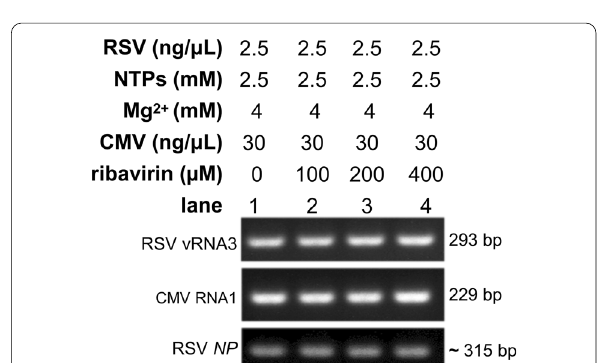
Fig. 5 The effect of ribavirin on the transcription of RSV. The chimeric RSV mRNA (RSV NP ) produced in vitro from each reaction with a mixture as indicated on top of the gel was amplified by RT-PCR. Similar nested RT-PCR was conducted to detect RSV and CMV genomic RNAs. The RT-PCR product was electrophoresed in a 1.5% agarose gel before being